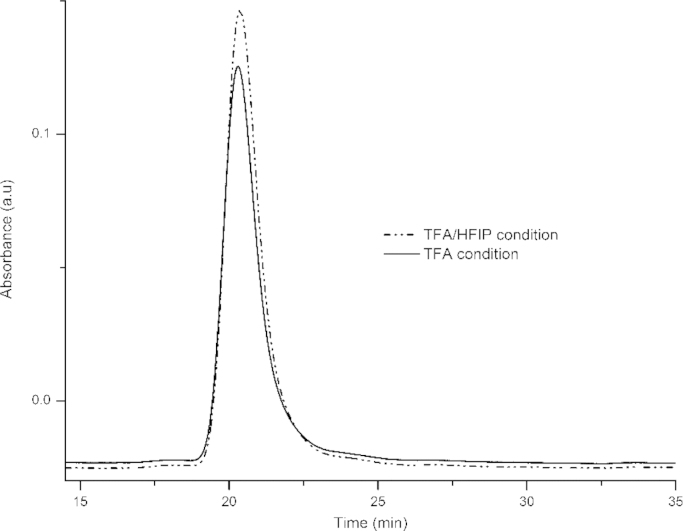
Size exclusion chromatograms of PGQ9I peptide in water-TFA (pH 3.0).